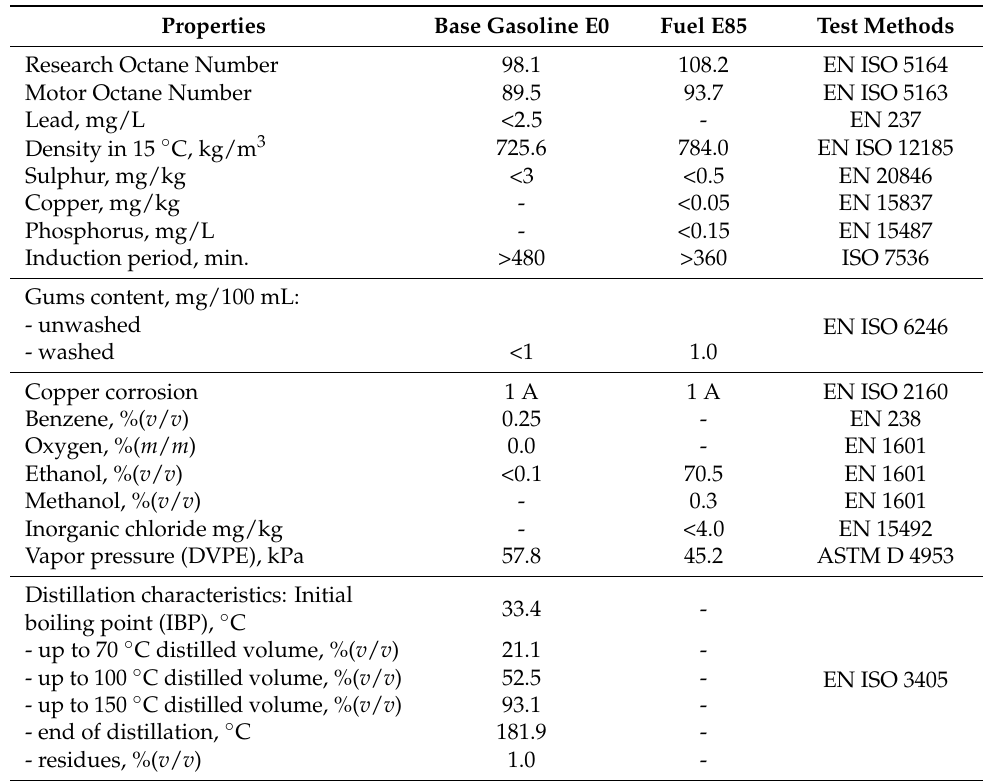
Figure 2. Scheme of the 3,4-dihydro-2H-1,3-benzoxazine synthesis reaction.